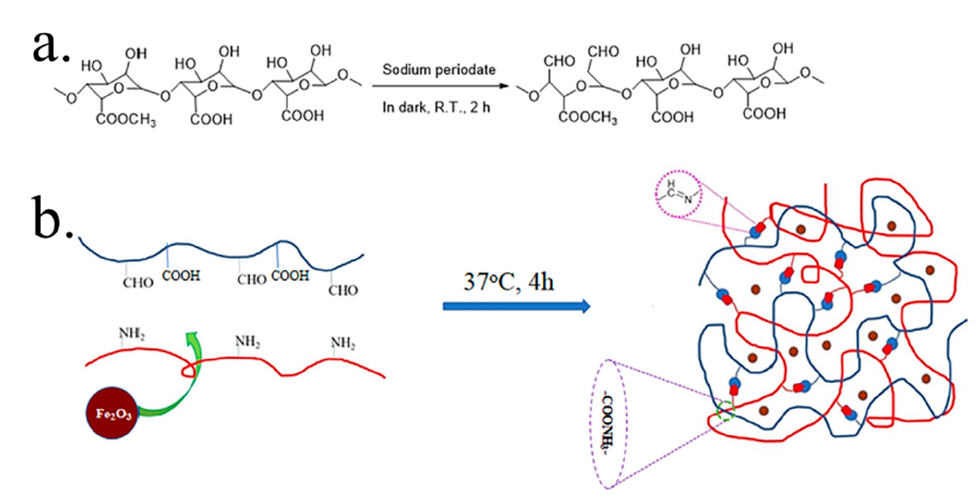
Figure 6. Proposed scheme ( a ) oxidation reaction and ( b ) hydrogel formation process. Reproduced with permission [58].